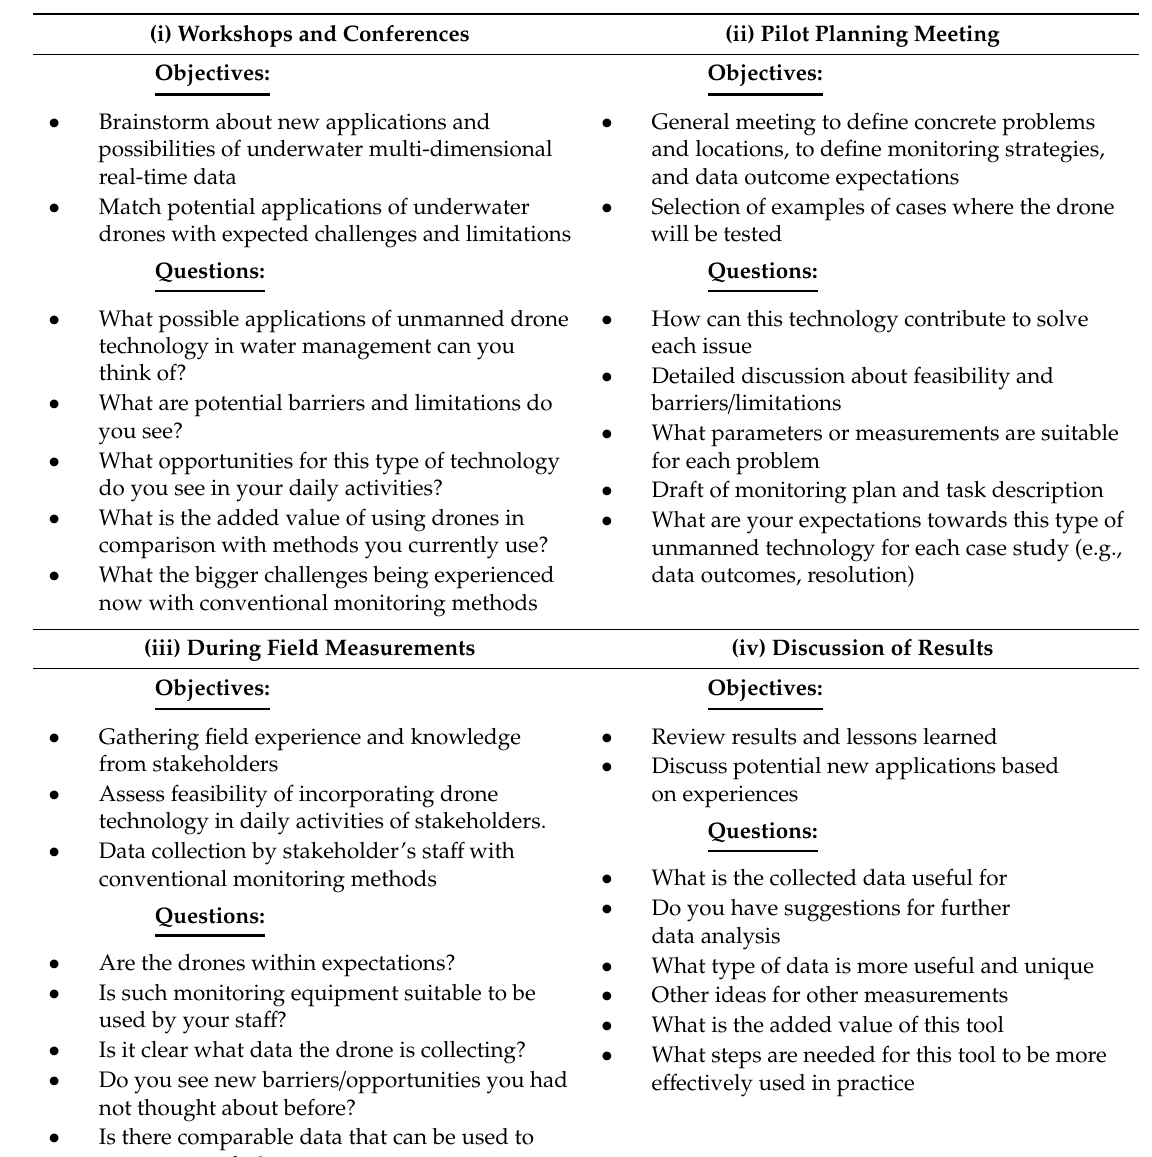
Table 4. Objectives and examples of questions asked to water managers during di ff erent steps of the